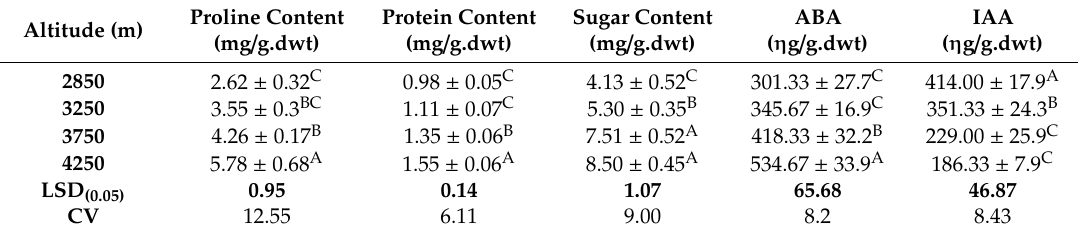
Table 2. Ecophysiological plasticity observed in Bistorta affinis through the analysis of proline, protein, and sugar contents, and abscisic acid (ABA) and indole acetic acid (IAA) concentrations.